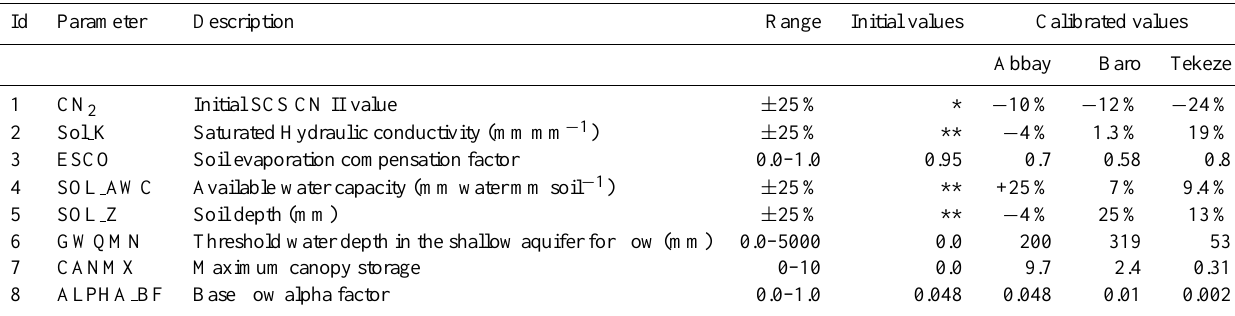
Table 4. List of adjusted parameters with calibrated values after manual and automatic calibration at the selected outlets for three subbasins of Eastern Nile using SWAT 2005